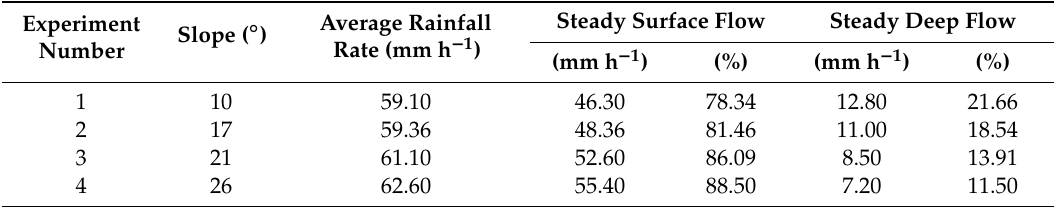
Table 2. Steady surface and deep flows for di ff erent laboratory slope gradients under a rainfall rate of about 60 mm h − 1 . Soil 4 of Figure 6 is